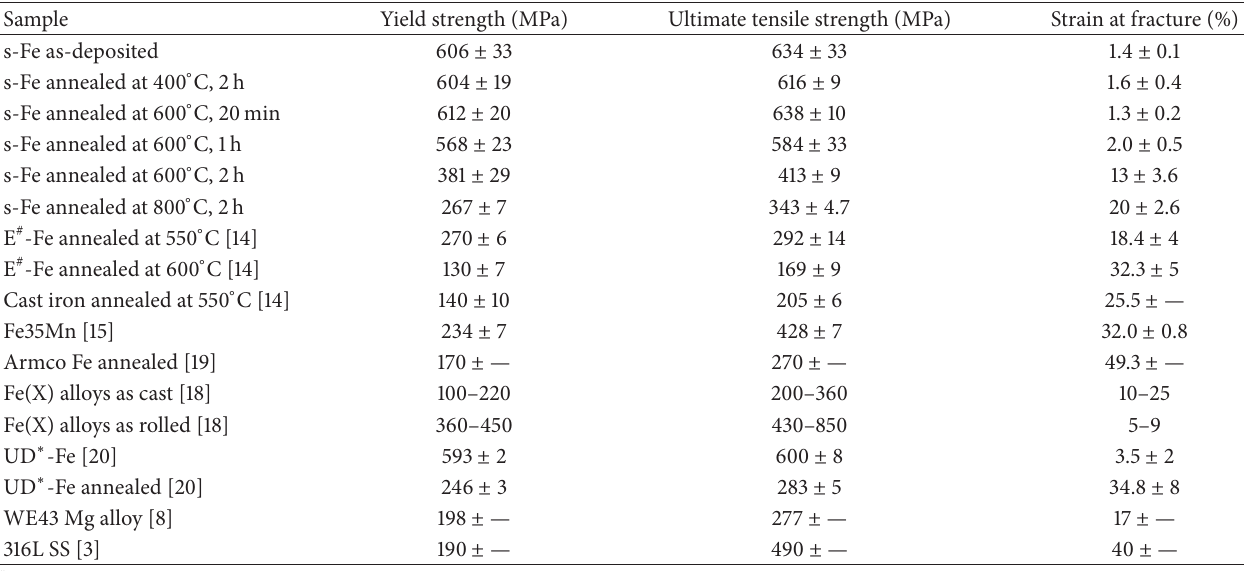
Figure 4: STEM images of s-Fe annealed at different temperatures for two hours. Table 2: Measured mechanical properties of s-Fe after different annealing treatments and published literature